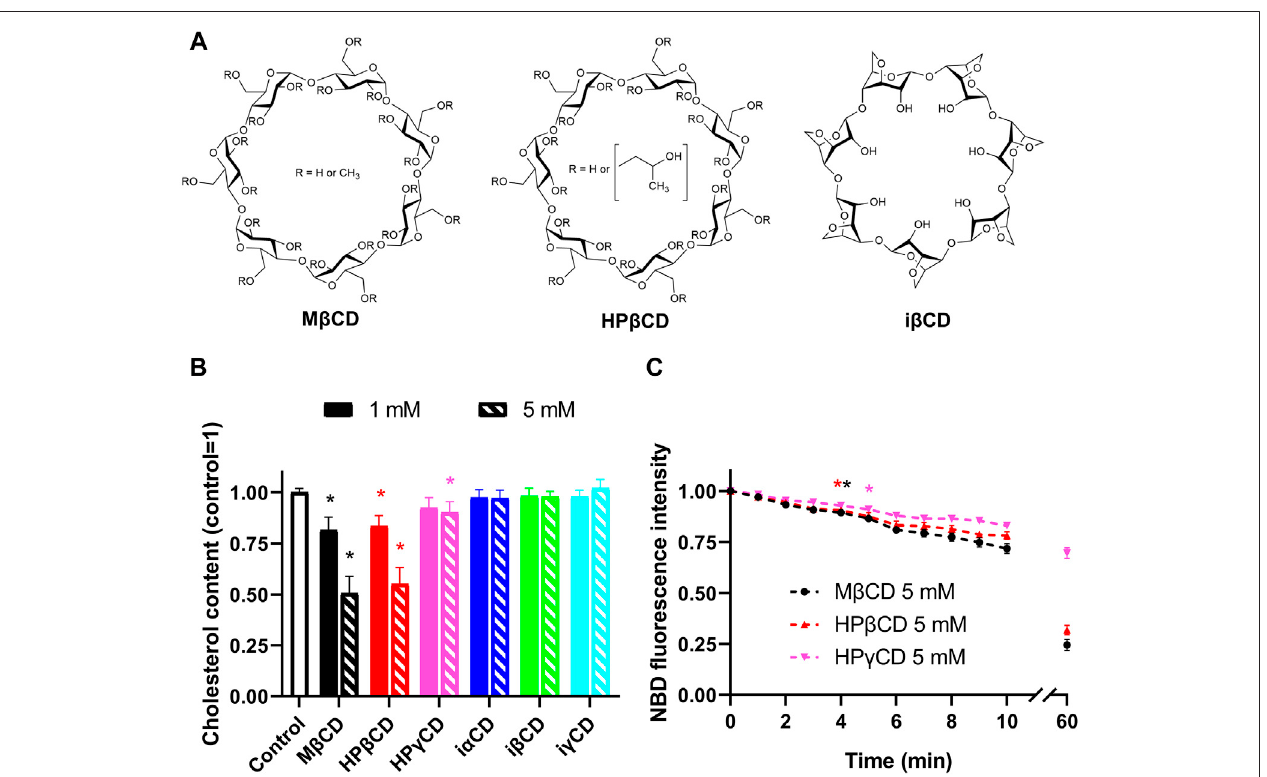
FIGURE 1 | Chemical structures and membrane cholesterol-extracting effects of CDs. (A) CDs typically consist of six, seven, or eight alpha-D-glucopyranoside units, which are referred toas α -, β -, and γ CDs. When comparingring-like structuresof conventional and “ inverted ” Per(3,6-anhydro)-CDs, theformer are characterized by a hydrophobic internal cavity and a hydrophilic outer surface, and different side-chain substitutions fi ne-tune their chemical properties. M β CD, the most commonly applied derivative for cholesterol depletion in vitro , is randomly methylated as indicated by R groups in the fi gure, while HP β CD, the CD most widely used for cholesterol extraction in vivo , contains random substitutions with hydroxypropyl groups in these positions. On the other hand, iCDs such as i β CD are single isomers not modi fi edontheirglucosehydroxylgroupsbuttheirglucosecoreisitselfmodi fi ed,i.e.,the 4 C 1 chairconformationofthenaturalglucopyranoseunitsaretransformed into fi cation oftheconformation ofglucose units causesadramatic change in lipophilicity pro fi le,as these compounds arecharacterized by ahydrophilic 1 C 4 form. This modi interior and a hydrophobic outer surface leading to preferential entrapment of hydrophilic guests. (B) CHO cells were treated with 1 or 5 mM CDs for 1 h followed by determination of cholesterol levels using fl uorometric cholesterol quantitation kit. While conventional CDs induced dose-dependent decreases in membrane cholesterol contentsaccordingtotheef fi cacyorderM β CD > HP β CD > HP γ CD, iCDsdidnotreducecholesterollevels. (C) Kinetics ofcholesterolextractioninresponsetoCDswas examined after pre-loading CHO cells with 200 µM NBD-conjugated cholesterol complexed with M β CD for 1 h. Then, time-dependent changes in NBD fl uorescence intensities induced by CDs were measured using time-resolved fl ow cytometry. Treatments started in the sample holder of the fl ow cytometer immediately before initiation of measurements. Moving averages of time-correlated fl uorescence intensity values of approximately 300,000 cells per sample were calculated with a window size of 20 s and subsequently normalized to average intensities determined in the fi rst time window. Time-dependent reductions in fl uorescence intensities were observedinresponsetoallthreeexaminedconventionalCDs withtheef fi cacyorderM β CD > HP β CD > HP γ CD. Firstsigni fi cantchangesappeared 240,220,and 300 s after the initiation of treatments, respectively. Data are represented as mean ± SEM obtained from n (cid:1) 6 independent experiments. Asterisks (*) indicate signi fi cant differences compared to control samples ( p < 0.05, ANOVA followed by Tukey ’ s HSD test). For clarity, in panel B every third point is shown and the fi rst time point is marked by an asterisk where signi fi cant difference is observed in response to the given